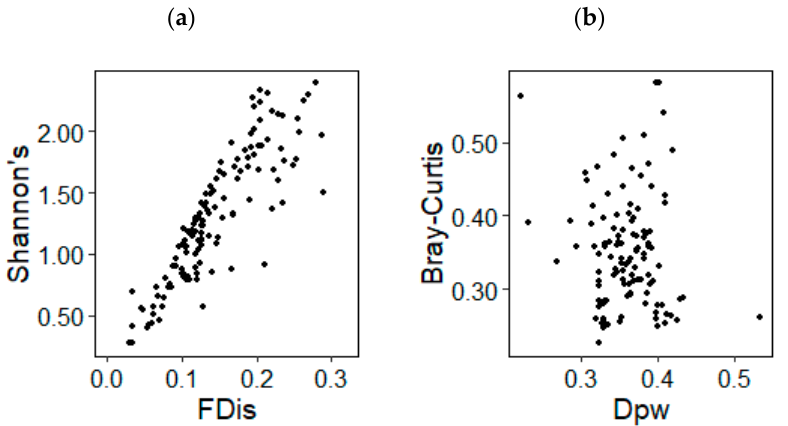
Figure 2. ( a ) Relationship between alpha FD (functional dispersion) and alpha TD (Shannon’s diversity), and ( b ) relationship between beta FD (functional pairwise dissimilarity) and beta TD (Bray–Curtis dissimilarity). FDis: functional dispersion; Dpw: functional pairwise dissimilarity.